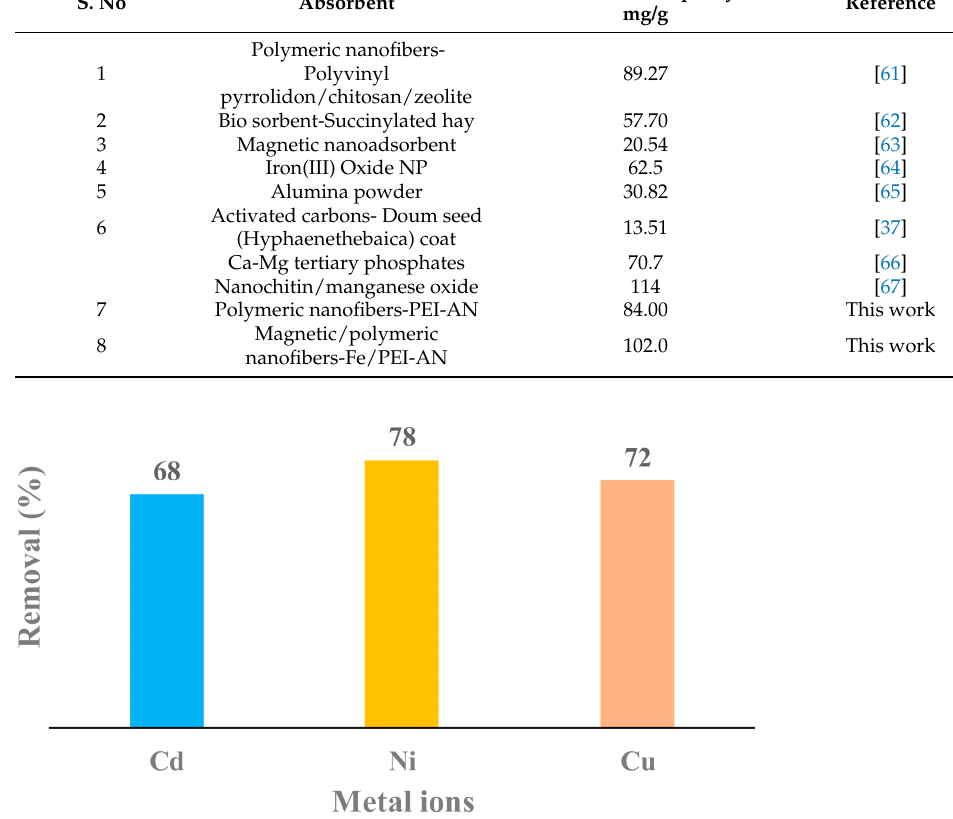
Figure 11. The preliminary adsorption study of Fe/PEI-AN composite adsorbent on different metal ions at pH = 7, time = 60 min, and dosage 18 mg (caution: these data are not optimized and are only provided to illustrate the reason to choose Ni 2+